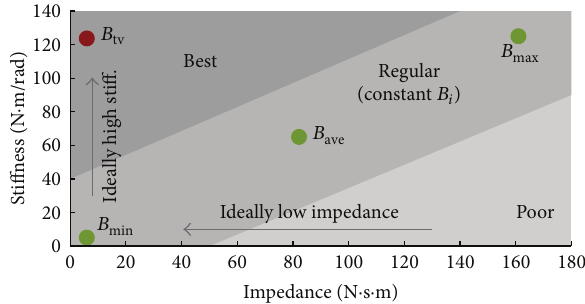
Figure 9: Impedance versus static stiffness perceived by the human operator during free motion and hard contact, respectively. Lower values of impedance and higher values of stiffness are